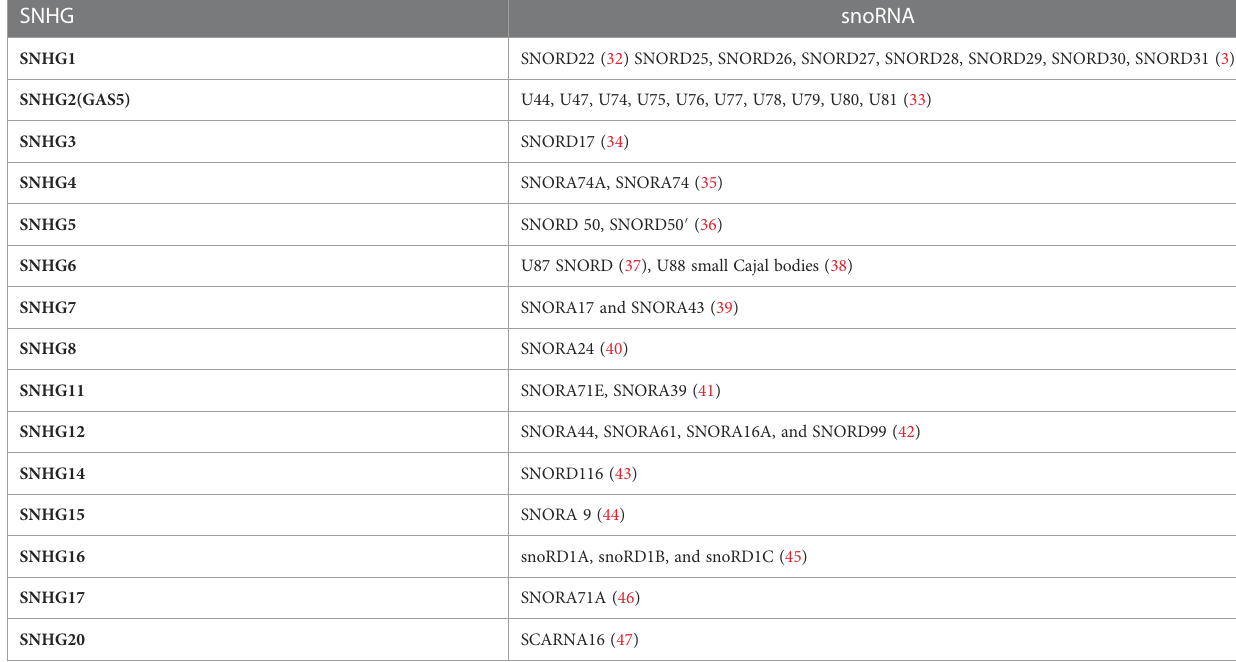
TABLE 1 SnoRNA in relation to